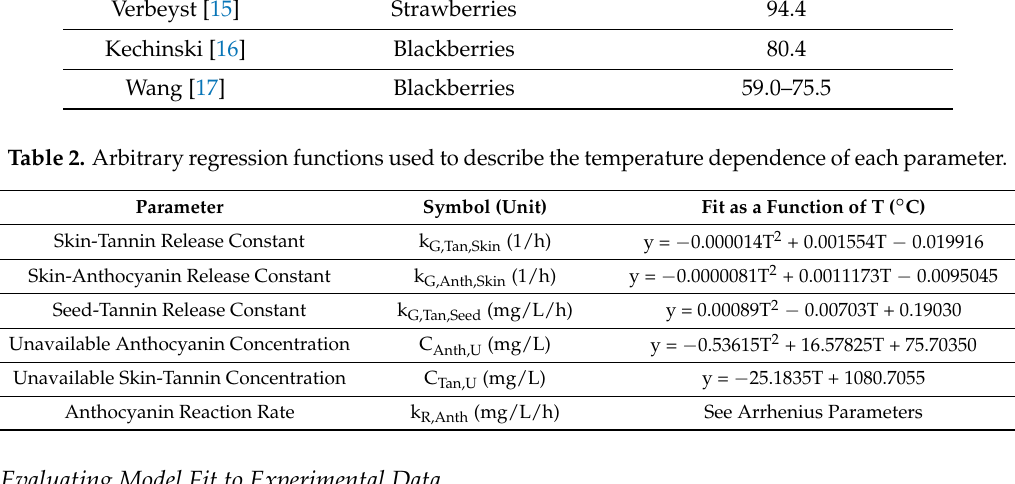
Figure 3. Extraction parameters as a function of temperature. ( A ) Skin-Tannin Release Constant, ( B ) Anthocyanin Release Constant, ( C ) Seed-Tannin Release Constant, ( D ) Anthocyanin Reaction Rate Constant, ( E ) Anthocyanin Unavailable, ( F ) Skin-Tannin Unavailable. Table 1. Activation Energies for Anthocyanin Degradation. Table 2. Arbitrary regression functions used to describe the temperature dependence of each parameter.